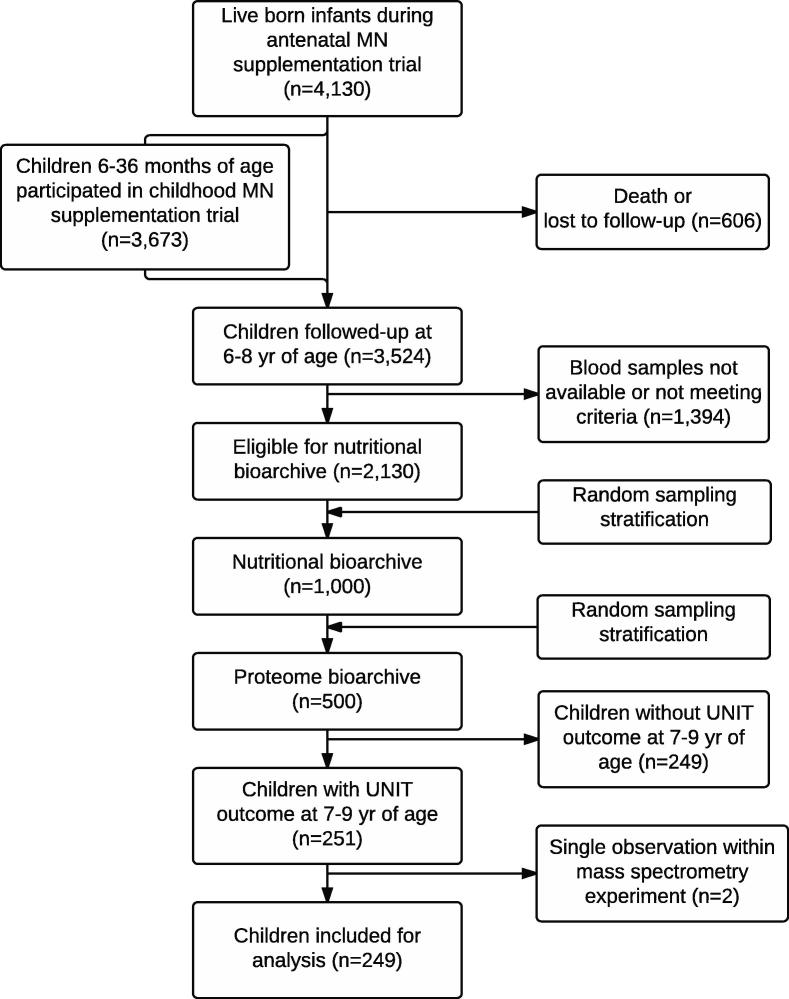
Consort diagram of study participants. Abbreviations: MN, micronutrient; UNIT, Universal Nonverbal Intelligence Test.